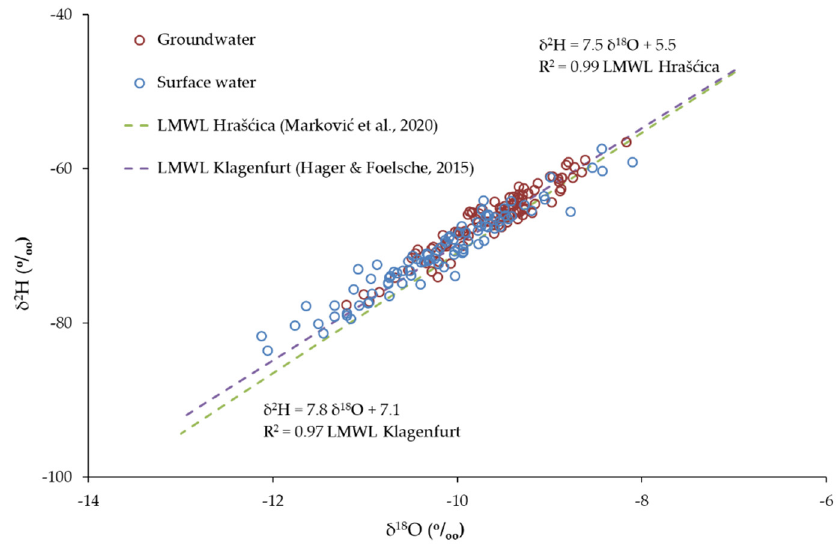
Figure 4. The relationship between δ 2 H and δ 18 O in groundwater and surface water. The presented local meteoric water lines are LMWL Klagenfurt and LMWL Hraš ć ica.